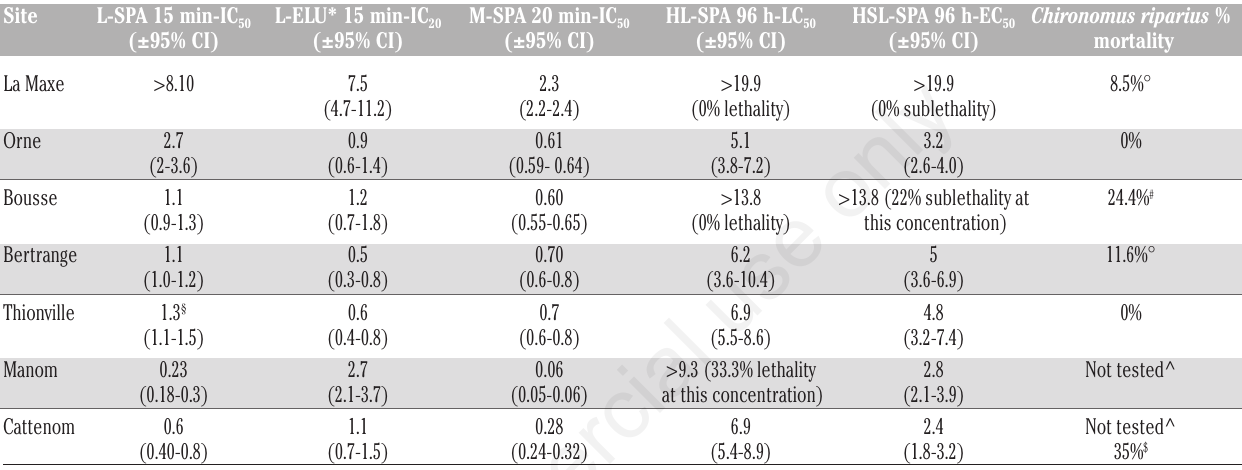
Table 3. Ecotoxicity data generated with the Moselle river watershed sediments: solid phase assay results are expressed in % dry weight (g/100 mL) and the elutriate assay in % w/v of sediment elutriate. Site